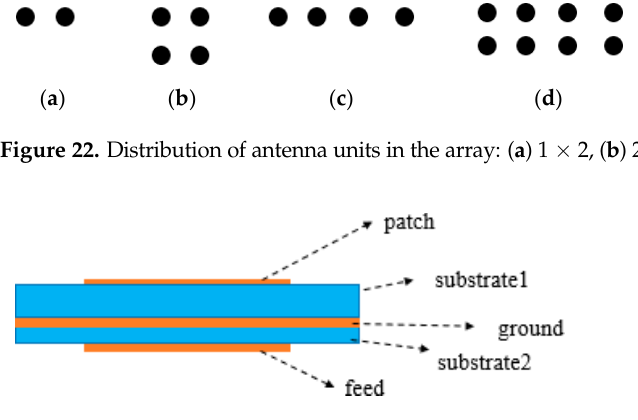
Figure 23. Side view of the array antenna.